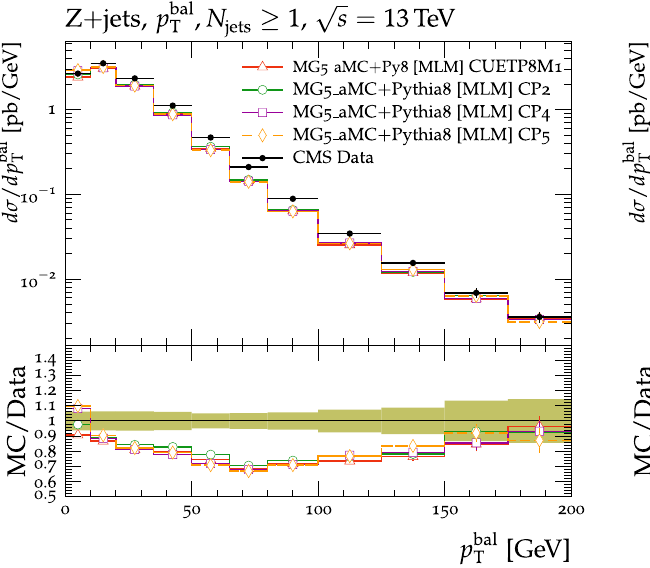
to the data (MC/Data) are also shown, where the shaded band indicates thetotalexperimentaluncertaintyinthedata.Verticallinesdrawnonthe data points refer to the total uncertainty in the data. Vertical lines drawn on the MC points refer to the statistical uncertainty in the predictions. Horizontal bars indicate the associated bin width